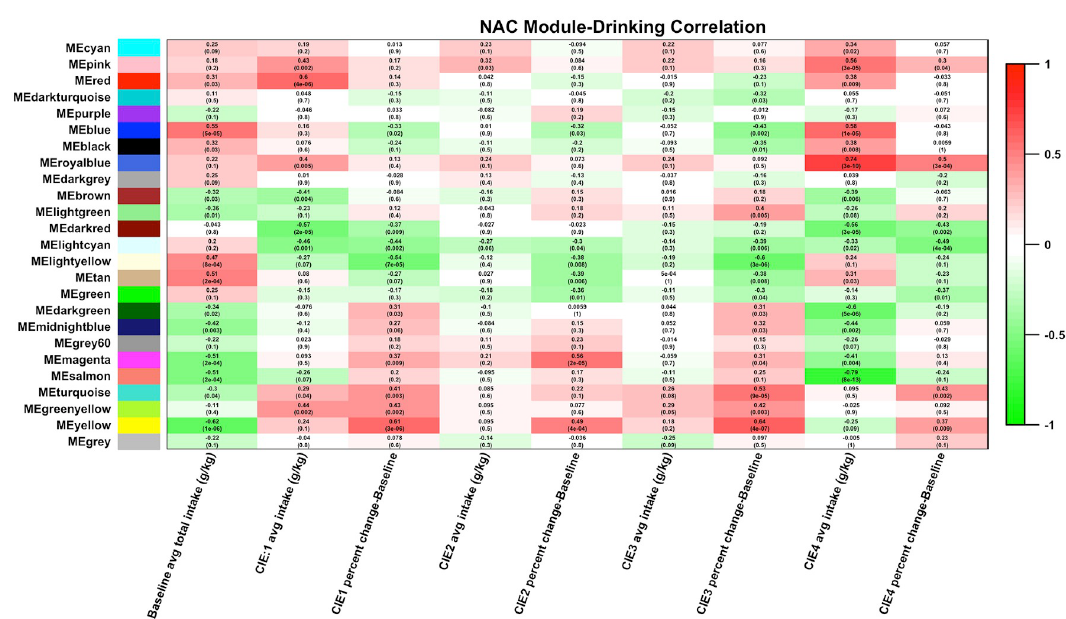
Fig 8. Heatmap of correlation between NAC modules and ethanol intake. Module eigengene (ME) values (1st principal component of gene expression) were correlated to ethanol intake measures. Cell color indicates strength of correlation (green = negative correlation, red = positive correlation).